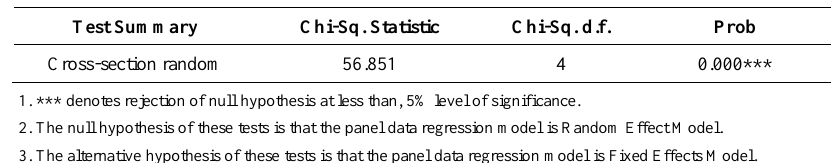
Table 5. Hausman Test.